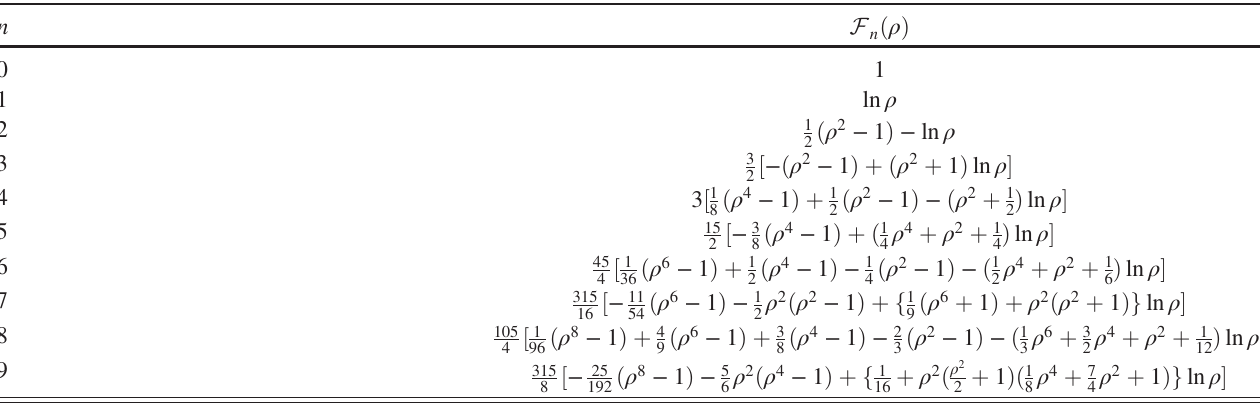
respectively.TABLE TABLE III. First ten members of G FIG. 3. First five even (top row) and odd (bottom row) members of regular polynomials P n ¼ ρ n , F n ð ρ Þ , G n ð ρ Þ from the left to the right,